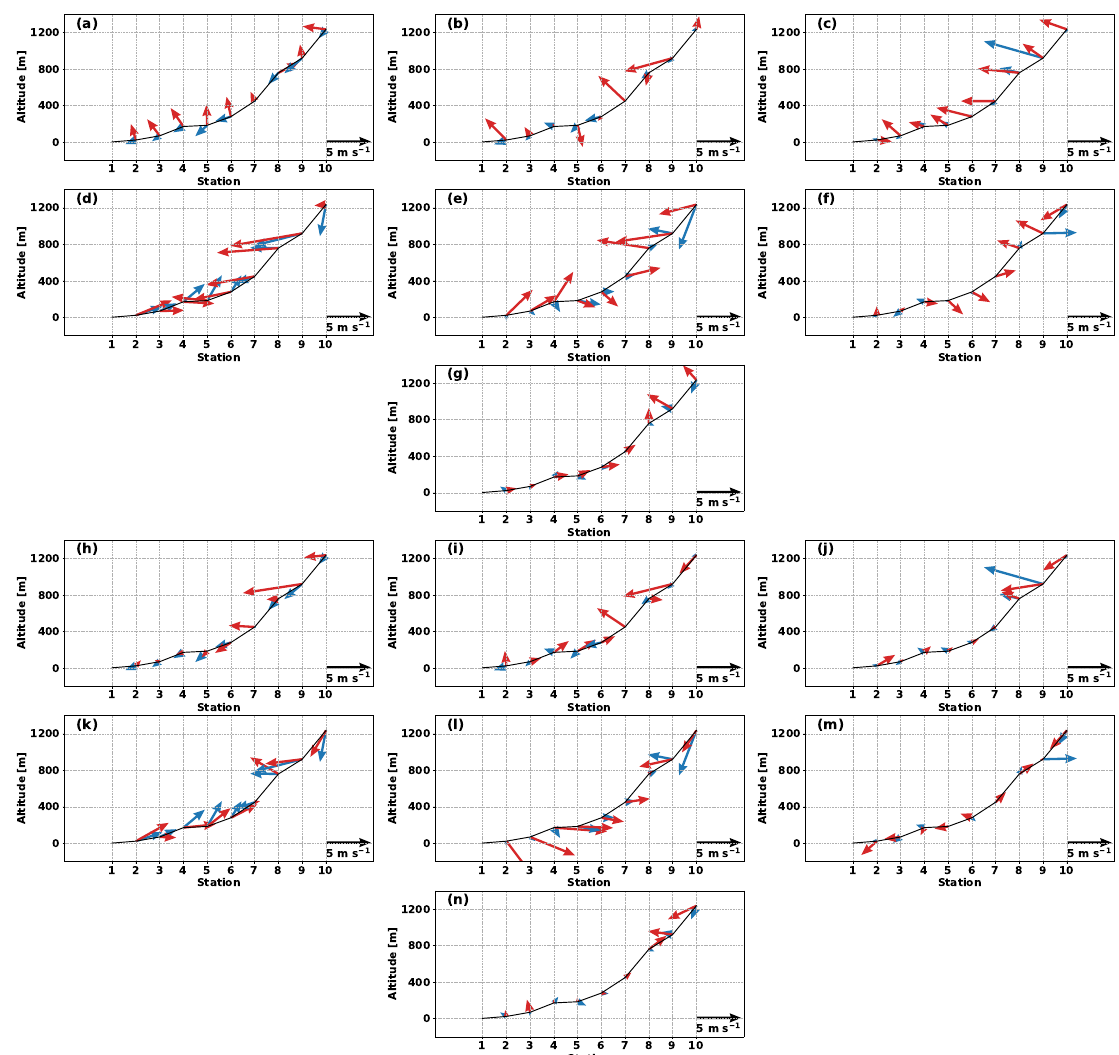
Figure 6. Observed (blue arrows) and D3 simulated (GrMRF and KFGS; red arrows) 10-m wind vectors (m s − 1 ) for 11 July 2004 at 03:00 LST ( a , h ), 06:00 LST ( b , i ), 09:00 LST ( c , j ), 12:00 LST ( d , k ), 15:00 LST ( e , l ), 18:00 LST ( f , m ), and 21:00 LST ( g , n ). LST: Local Solar